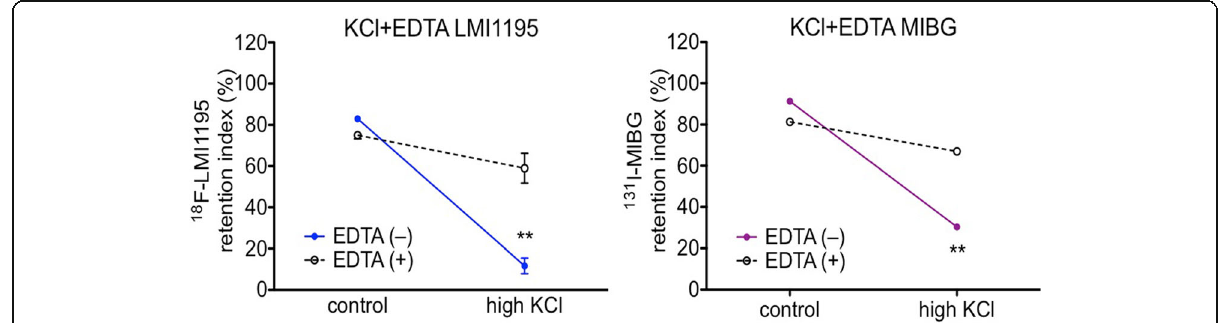
Fig. 2 Comparison of both tracers in PC12 cells treated with 100 mM KCl in the presence (+) or absence ( − ) of EDTA. Y -axis represents the difference of release index, i.e., counts over control after 30 min of treatment with high concentration KCl buffer. Both 18 F-LMI1195 ( n = 3 of each testing group) and 131 I-MIBG ( n = 3 of each testing group) were released from PC12 cells after treatment with high concentration KCl in the absence of EDTA, whereas the effect was mitigated in the presence of EDTA. ** p < 0.005 vs. EDTA (+) group at the same condition; all data points presented as mean ±